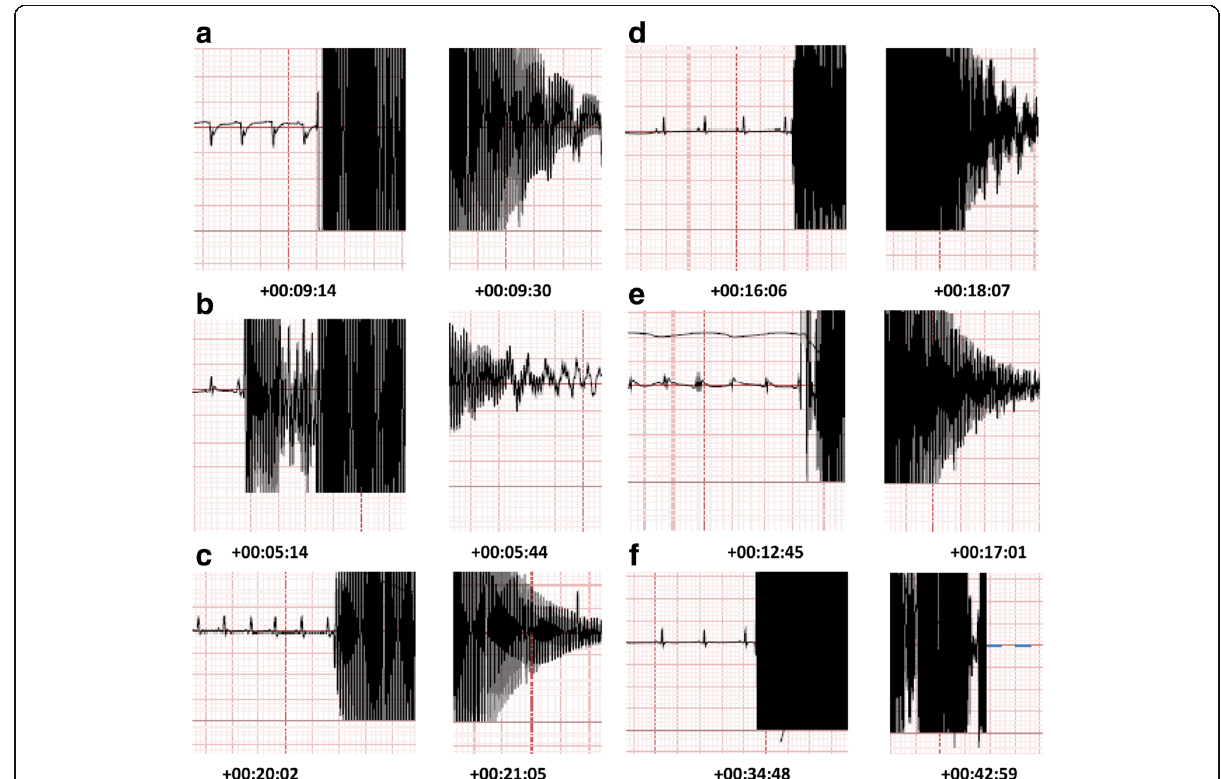
Fig. 1 Electrocardiograms of six durations of global ischaemia generated by trans-oesophagus AC current, confirmed by cardiac arrest (CA). a 15 s of CA b 30 s of CA c 1 min of CA d 2 min of CA e 4 min of CA f 8 min of